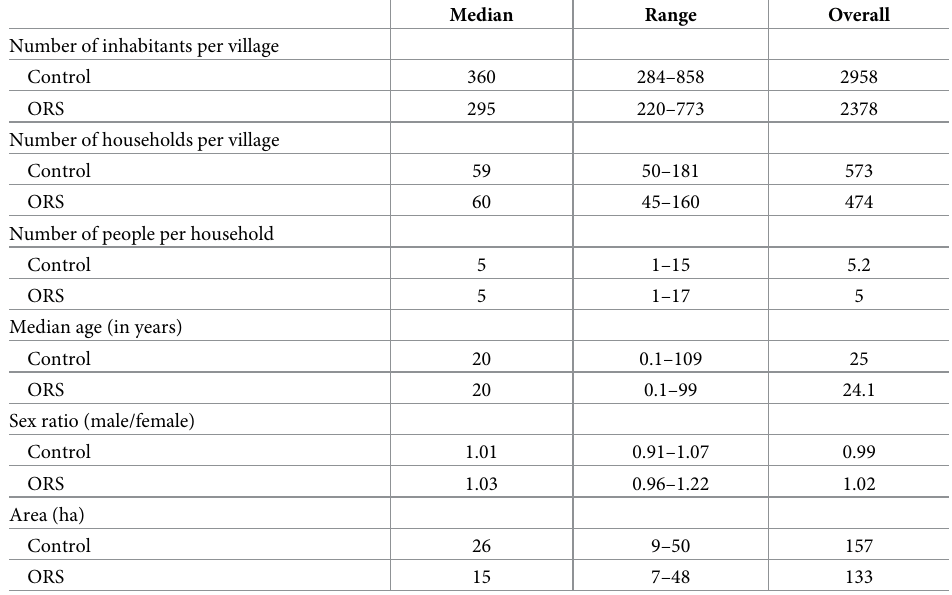
Table 1. Demographic and environmental characteristics of the villages in the two groups.